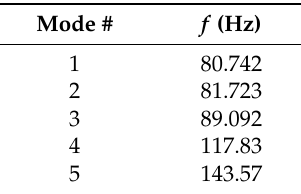
Table 4. FE calculated natural frequencies of the Transfer Machine with nine